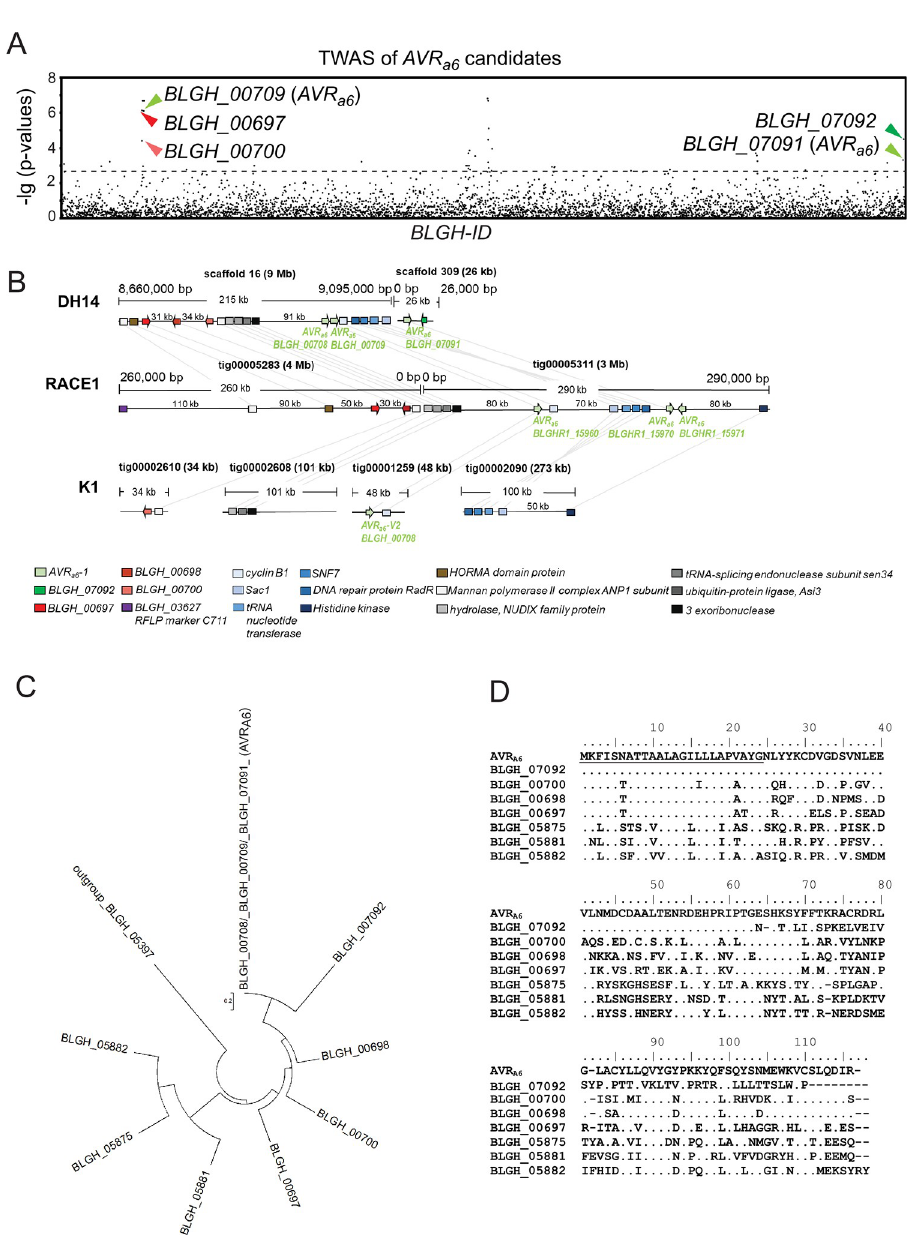
Fig 1. Identification of BLGH_00709 ( CSEP0254 ) as one of the top ranking AVR a6 candidates by association of Bgh AVR a profiles on Mla6 near-isogenic lines with transcript polymorphisms. (A) Manhattan plot summarizing the gene-wise association results for candidate AVR a6 . The x axis represents the Bgh DH14 genes, sorted by Bgh gene ID; the y axis shows − lg of p-values for all genes with at least one nonsynonymous coding SNP, indels as well as presence or absence of transcripts. CSEPs with a p < 0.018 (dotted line) are depicted by arrowheads. The candidate AVR a6 gene copies BLGH_00709 ( CSEP0254 ) and BLGH_07091 are designated in the plot with bright green arrowheads. BLGH_07092 is designated by a dark green arrowhead. The other candidates BLGH_00697 ( CSEP0058 ) and BLGH_00700 are depicted with a dark red and a bright red arrowhead, respectively. (B) Schematic illustration of the chromosomal regions harboring the AVR candidate BLGH_00709 and its paralogues and family members with a6 corresponding gene IDs in the genomes of Bgh isolates DH14, RACE1, and K1. All CSEPs are depicted by arrows. (C) Phylogeny of CSEP family 8 containing AVR A6 , which can be divided into clade 1 (BLGH_00709, BLGH_07092, BLGH_00700, BLGH_00698, BLGH_00697) and clade 2 (BLGH_05882, BLGH_05875, BLGH_05881), based on the protein sequences excluding the signal peptide and using BLGH_05397 as an outgroup. (D) Protein sequence alignment of AVR A6 and CSEP family 8 members including their respective signal